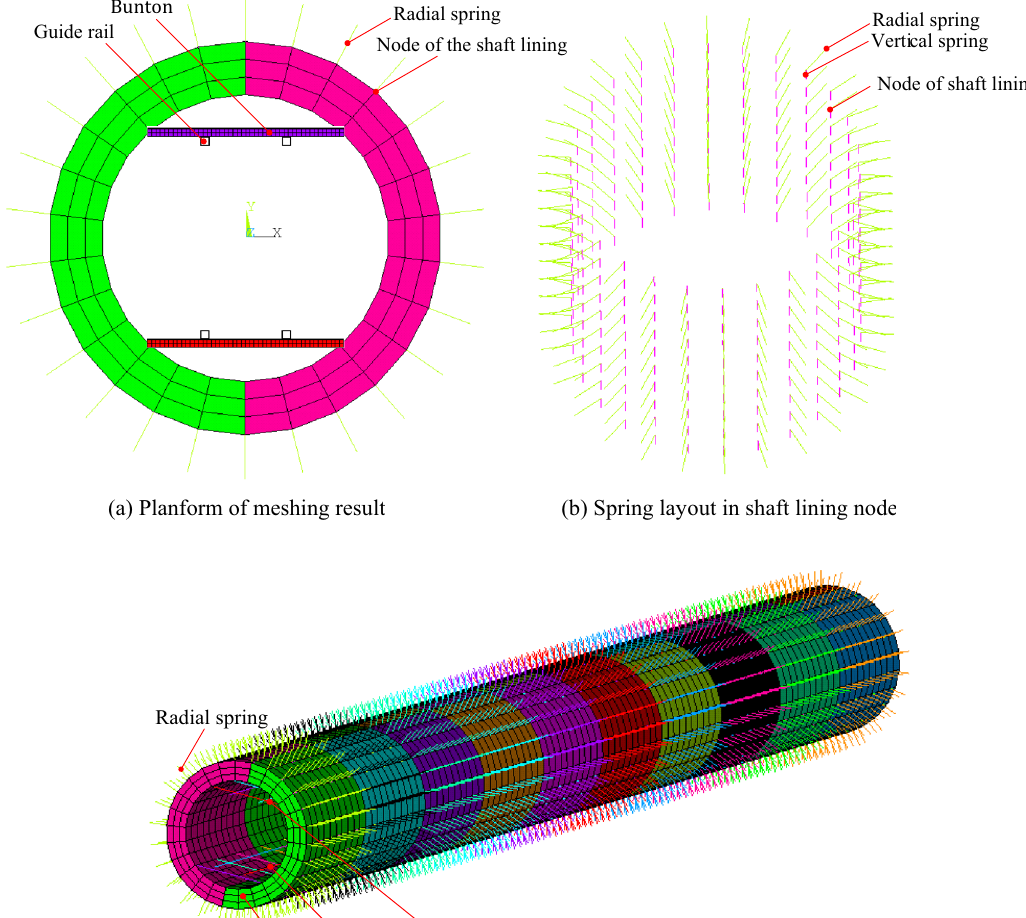
liningVertical Node of shaft